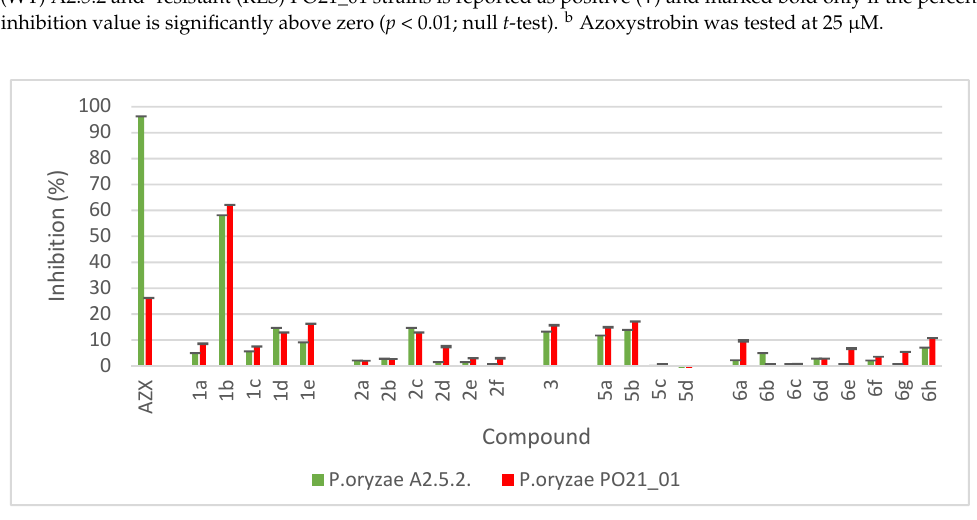
Figure 3. Inhibition of mycelium growth of Pyricularia oryzae QoI-sensitive A2.5.2. (green) and -resistant PO21_01 (red) strains on malt extract agar by the tested compounds of the series 1 – 6 and azoxystrobin (AZX) at a concentration 25 mg/L a.i. Error bars represent the standard deviation of the mean.